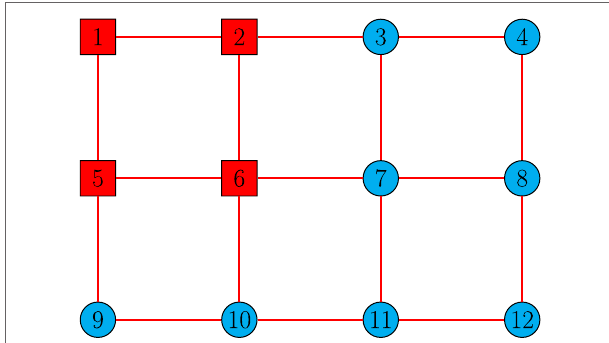
FIGURE 2 | Communication graph of the sensor network in Example 1 with 4 active nodes and 8 passive nodes (lines denote communication links, squares denote active nodes, and circles denote passive nodes) Tran et al. (2017).